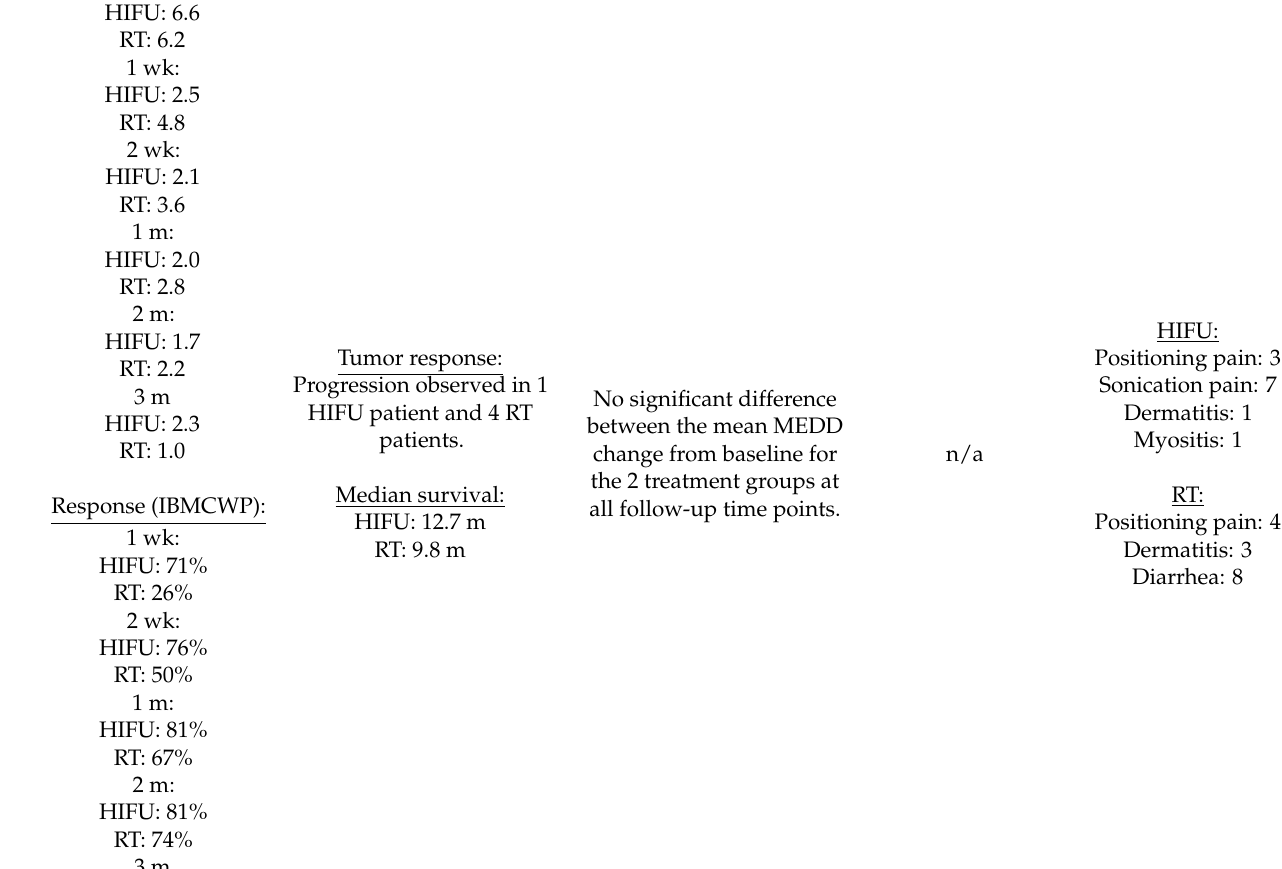
change from baseline for the 2 treatment groups at all follow-up time